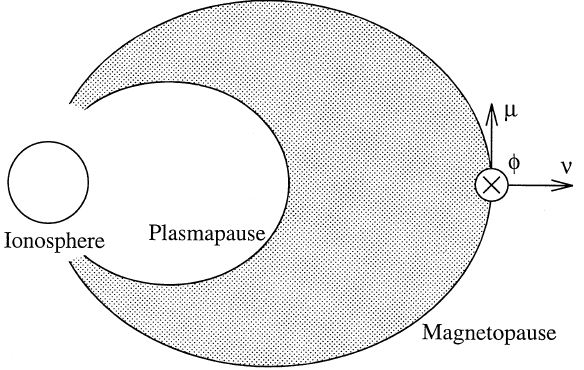
Fig. 1. The dipole magnetic field geometry with the coordinate system and the boundaries used in